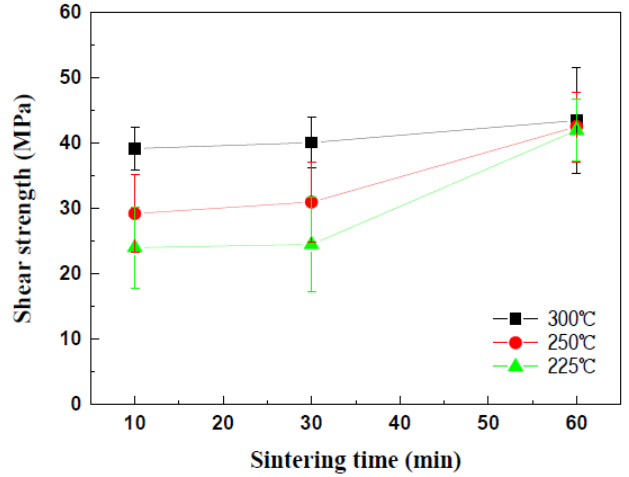
Figure 12. Variation in die shear strength with the sintering temperature and duration.